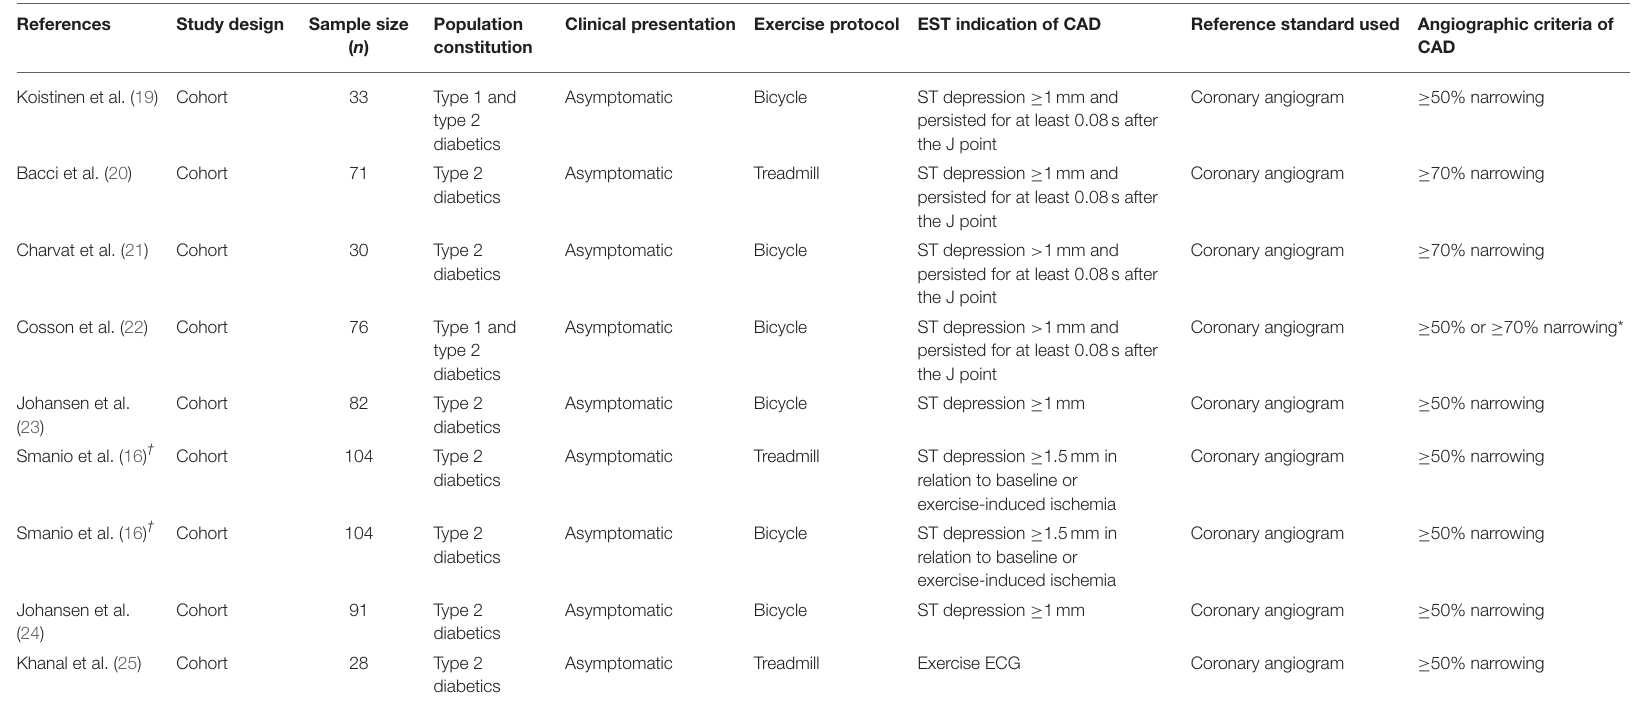
TABLE 2 | Characteristics of included studies.